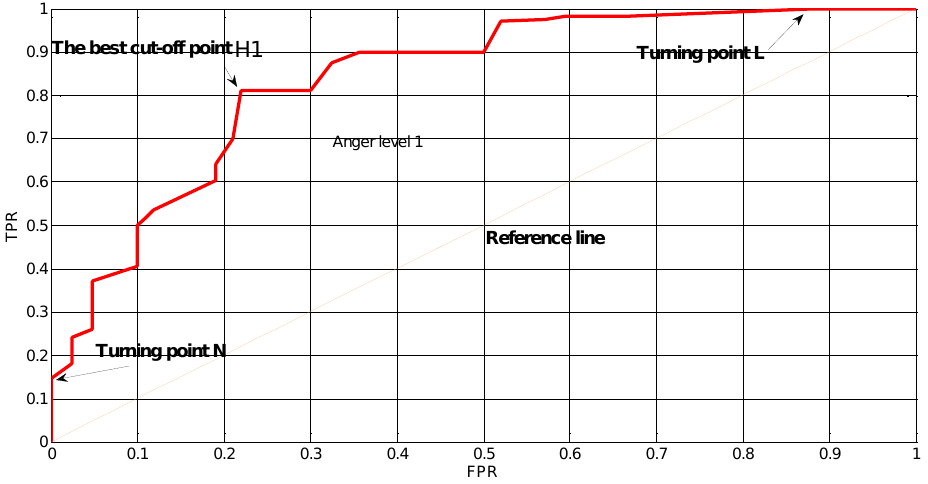
Figure 6. Drawing process of ROC curve and determining optimal threshold for discriminating driving anger level 1 from level 0 based on β% in Matlab codes.